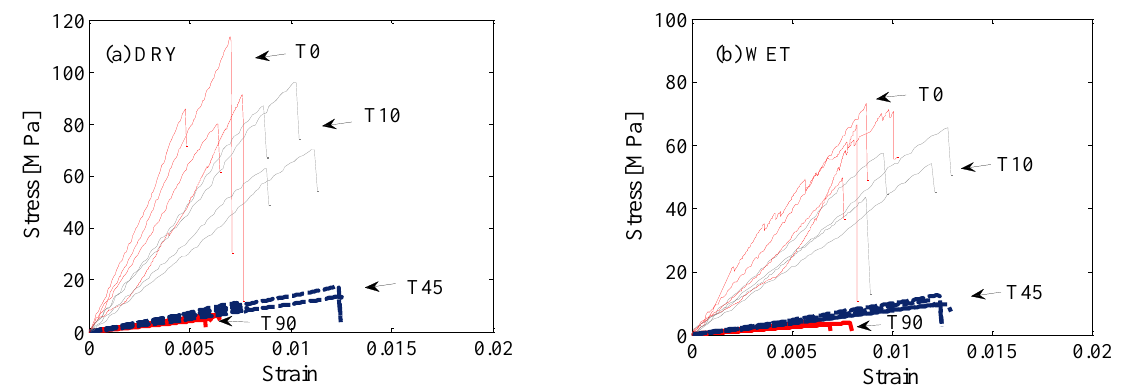
Figure 7. Stress–strain curves of E. nitens tensile samples with both low (dry) and high (wet) moisture contents for four angles α = 0°, 10°, 45°, and 90°; Left plot ( a ), dry samples; right plot ( b ), wet samples; T0, α = 0°; T10, α = 10°; T45, α = 45°; T90, α = 90°. The different lines in the same colour in each figure represent four representative replicate tests.